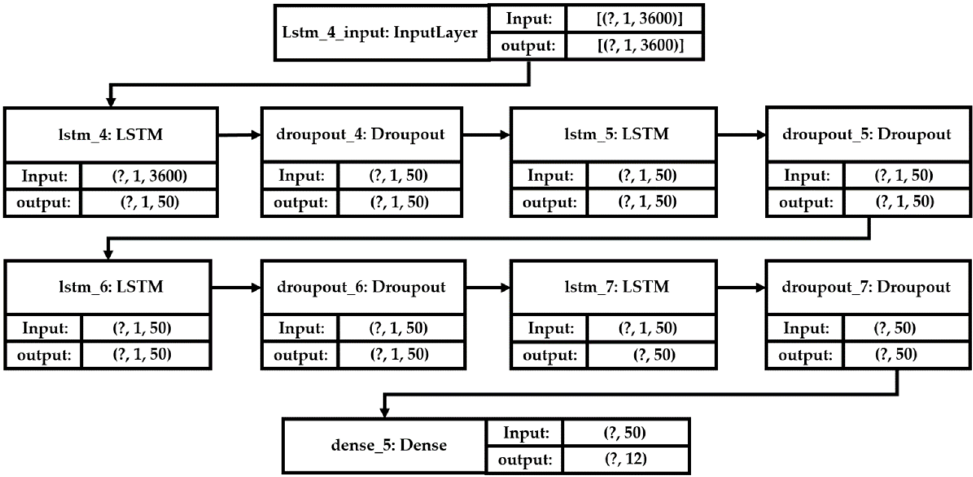
Figure 3. Proposed model architecture. Table 5. The best hyperparameters based on our empirical study.